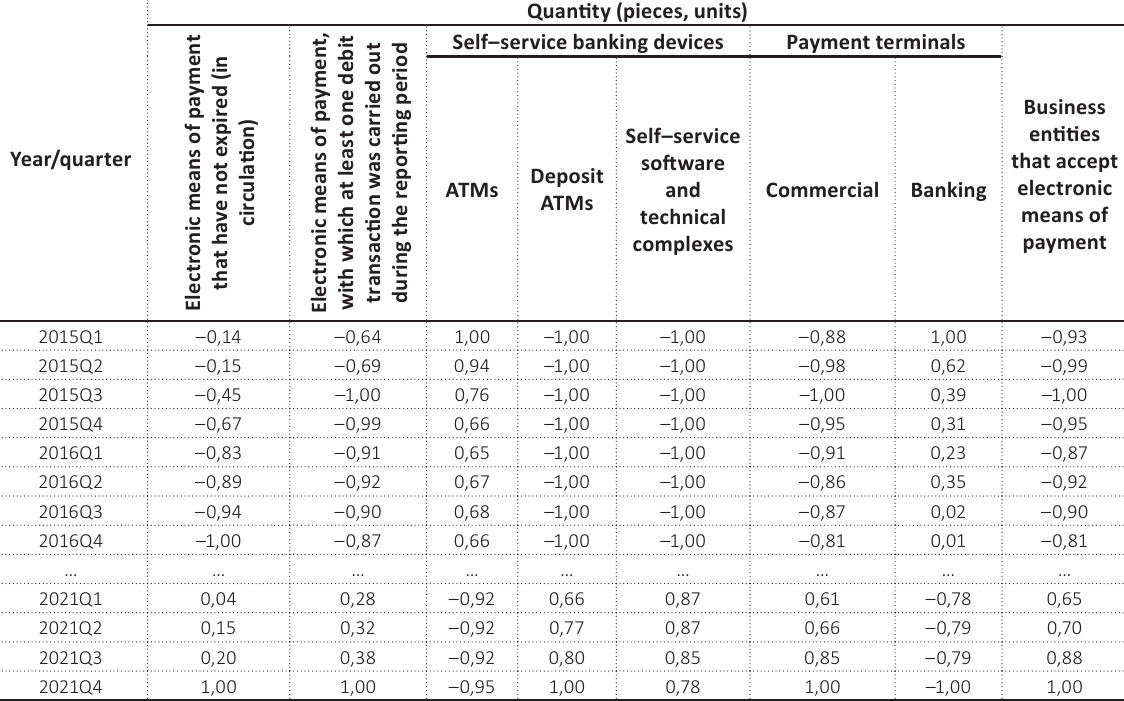
Table А12. Normalization of the values of digitalization specific indicators